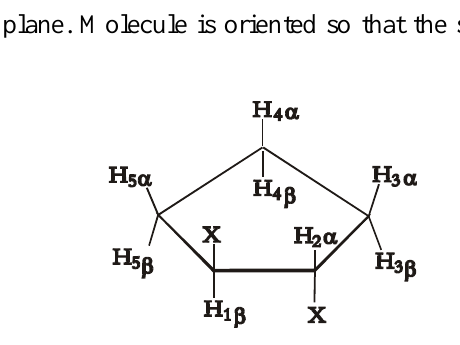
Figure 3. Proton numbering scheme for trans-1,2-disubstituted cyclopentanes. Theoretical